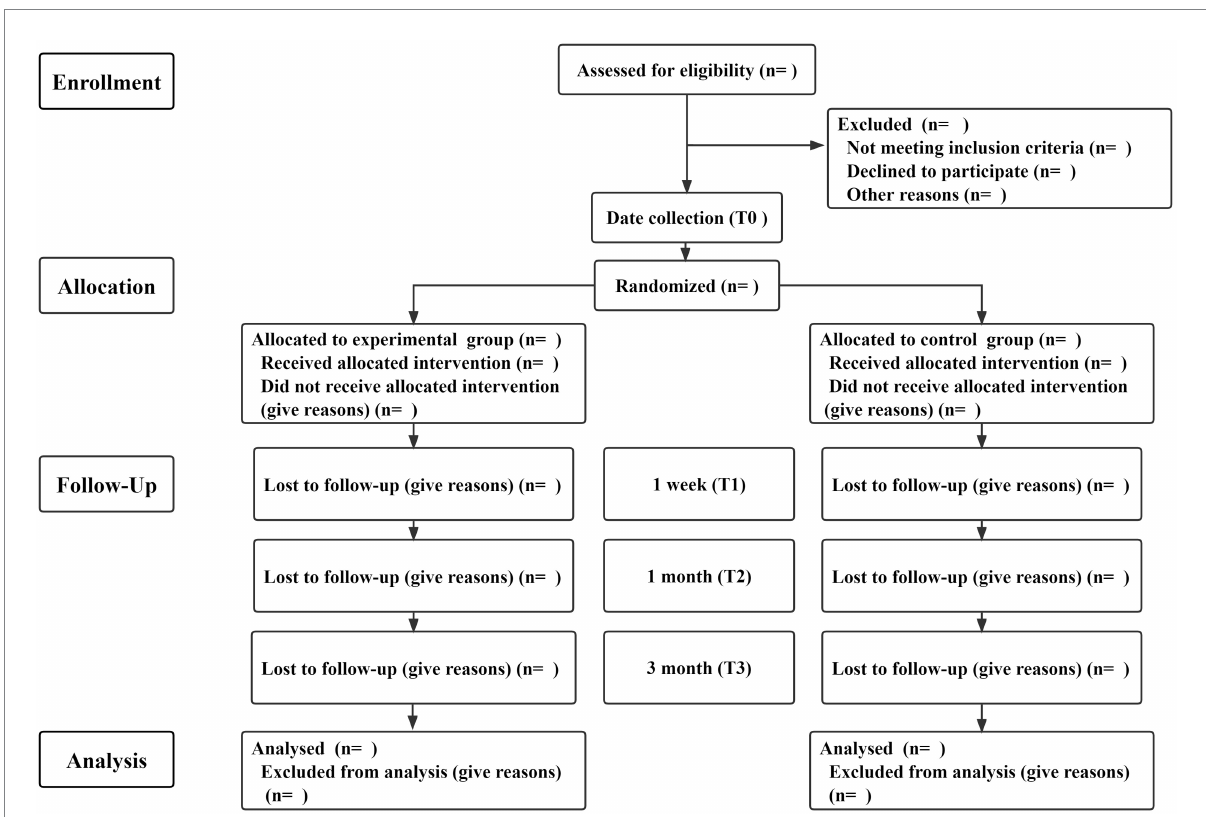
FIGURE 1 Consolidated Standards of Reporting Trials (CONSORT) flow